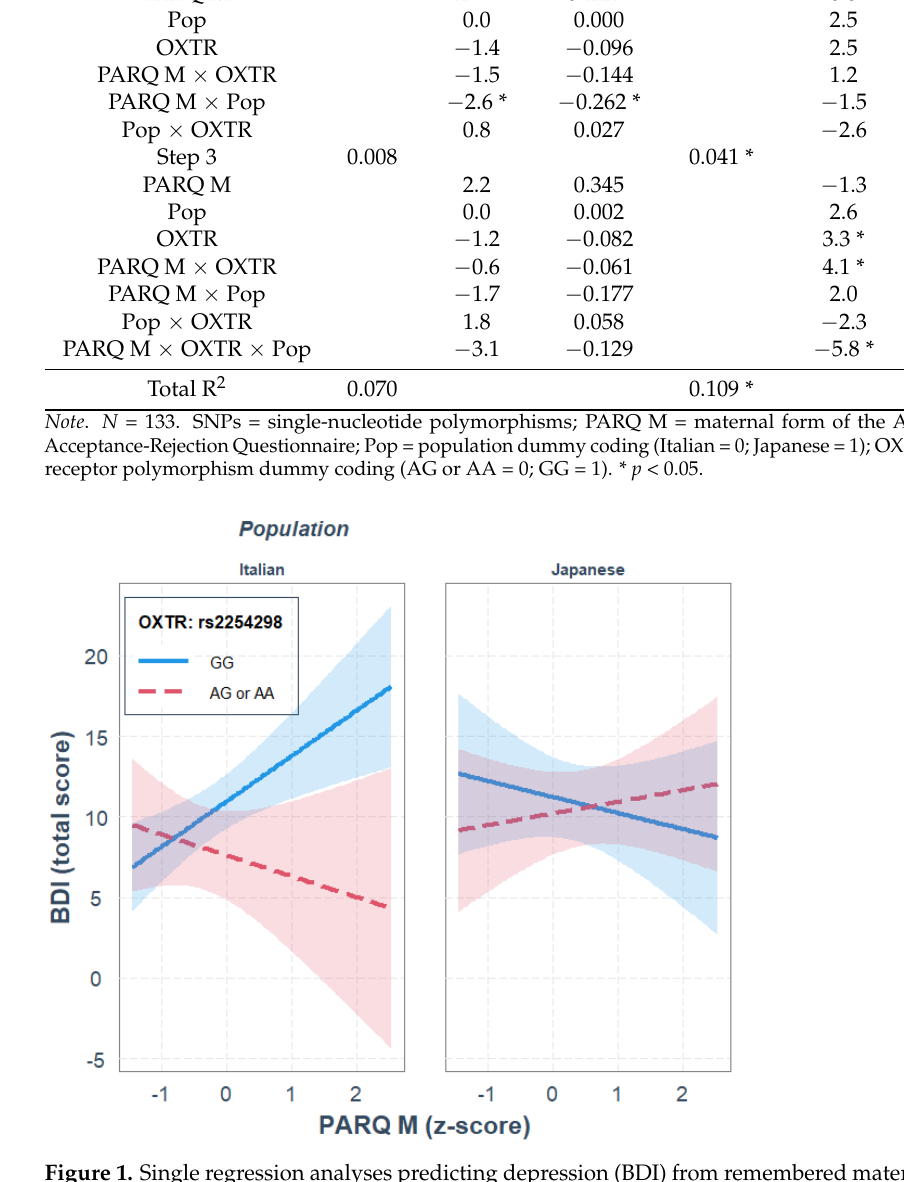
Figure 1. Single regression analyses predicting depression (BDI) from remembered maternal rejection as a function of OXTR rs2254298 gene polymorphism and population.